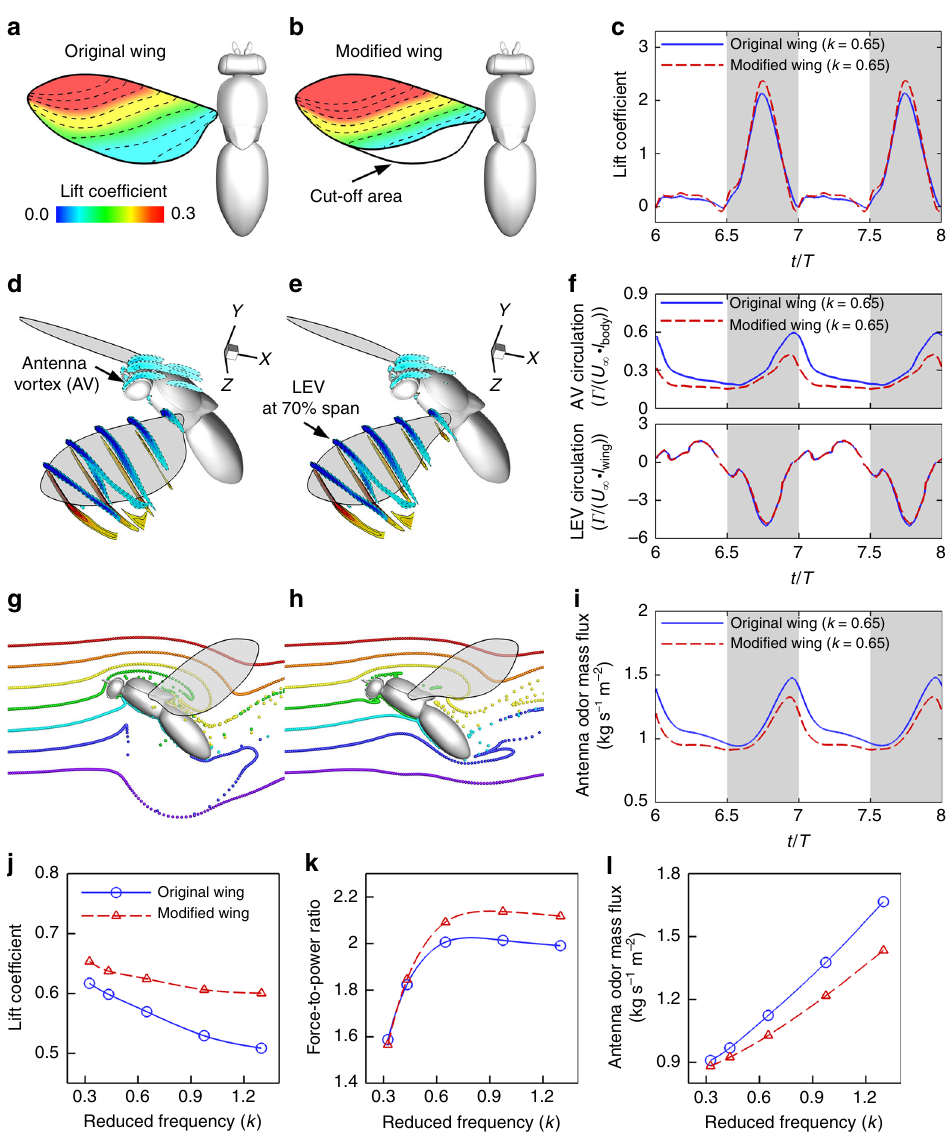
Fig. 3 Side-by-side comparisons between the original and modi fi ed wings. a , b Comparison between original and modi fi ed wings that cut off part of the trailing edge at k = 0.65. Color contour indicates the cycle-averaged lift coef fi cient on the wing surface. c Time course of lift coef fi cient. d , e Comparison of antenna vortex (AV) and leading-edge vortex (LEV) formation at the mid-downstroke. f Time course of vortex circulation of AV at the body center and LEV at 70% wingspan. g , h Odor plume structures visualized by neutral-buoyant particles. ( i ) Time course of odor mass fl ux over antennae. j – l Cycle-averaged lift coef fi cient ( j ), total force-to-power ratio ( k ), and odor mass fl ux at antenna ( l ) as function of the reduced frequency ( k ). The modi fi ed wings produced similar LEV ( f , bottom plot), better lift coef fi cient ( c , j ), better force-to-power ratio ( k ), but signi fi cantly worse antenna vortex ( f , top plot) and odor mass fl ux ( i , l ). Supplementary Fig. 1d. The inclination angle of the stroke plane ( β ) against the horizontal body axis is 20°. The entire body is inclined by χ = 45°with respect to the horizontal plane. The clipping of wing trailing edge discussed in the main text is based on the surface contour of the cycle-averaged lift coef fi cient of the original wing at k = 0.65 (Supplementary Fig. 5). The modi fi ed wing area and mean chord length are 2.09mm 2 and 0.73 mm, respectively. Numerical method . The numerical simulations were performed using a second- order Cartesian grid-based immersed boundary method. The details of this solver have been previously described; 24 brief descriptions are provided here.